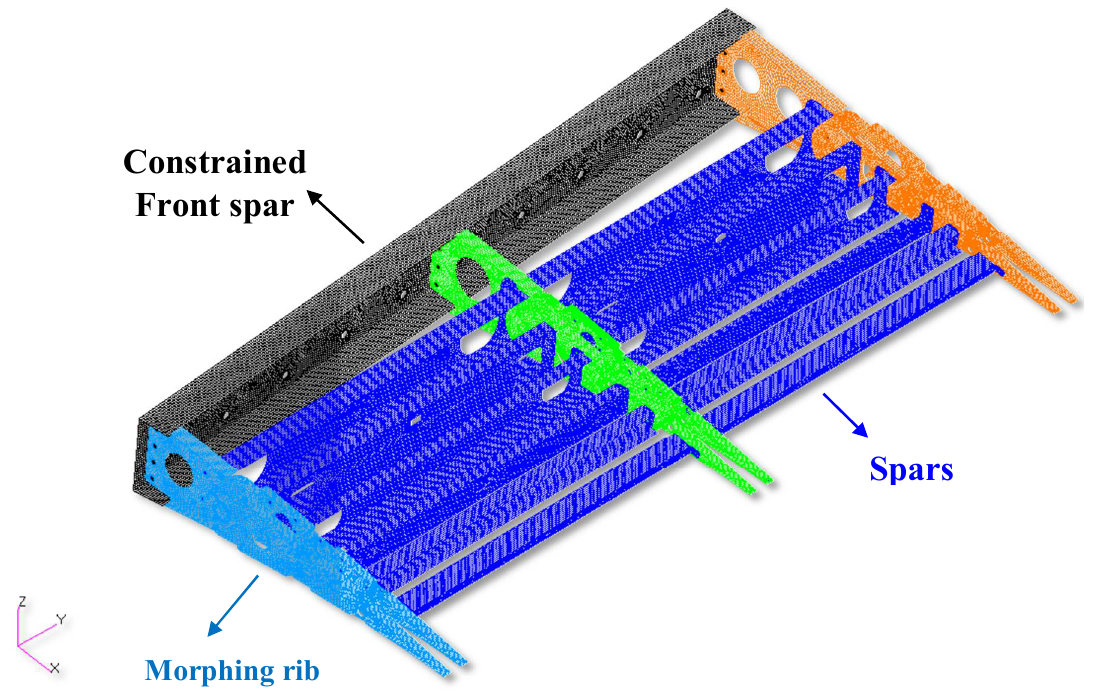
Figure 16. FEM representation of the trailing edge segment.